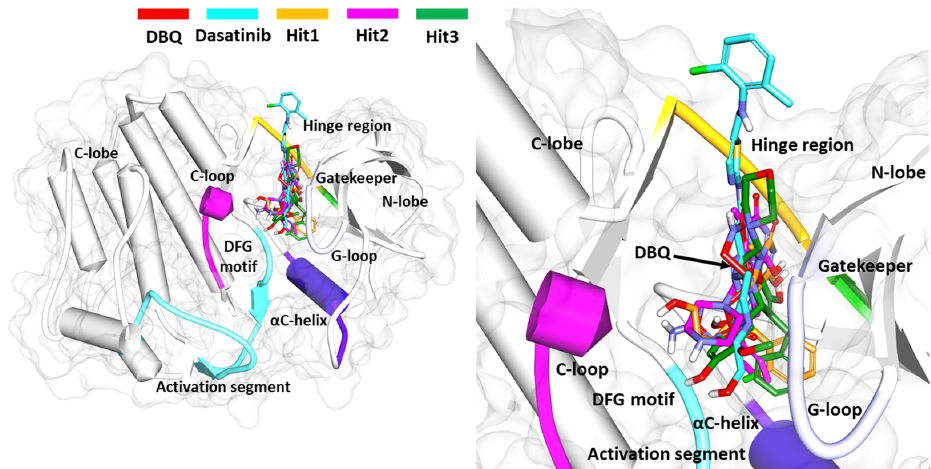
Figure 6. Binding mode of selected Hit compounds. Superimposition of simulated ACK1-inhibitor complexes. The protein is shown in schematic representation with a light gray color surface. The important regions forming the active site were highlighted. The inhibitors are shown in a stick representation with different color codes.